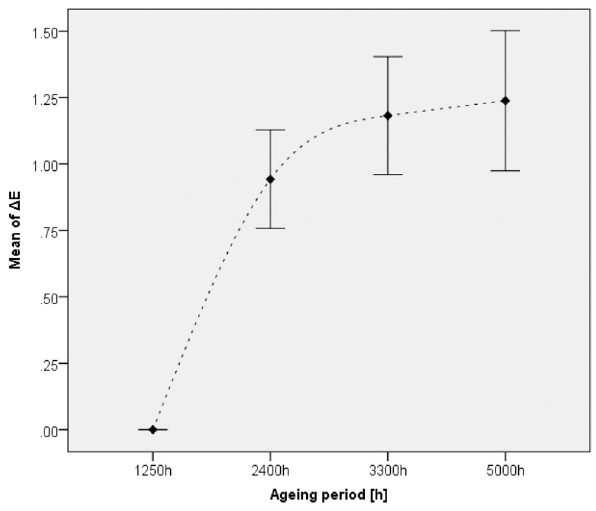
Figure 3. Correlation between colour change (mean of ΔE) and ageing period (hours).